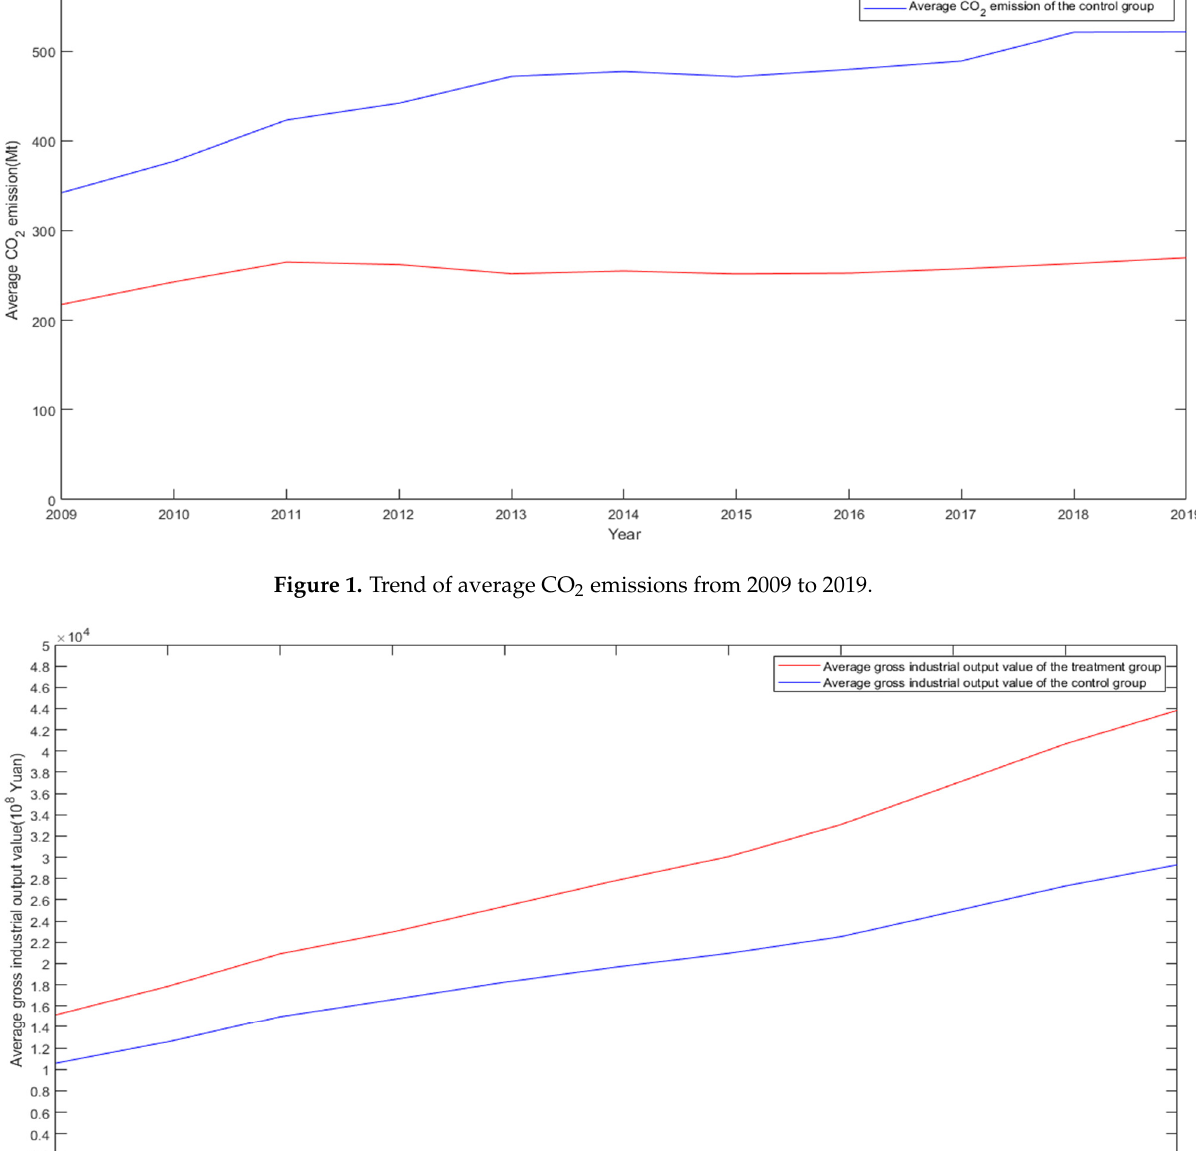
Figure 2. Trend of average GDP from 2009 to 2019.